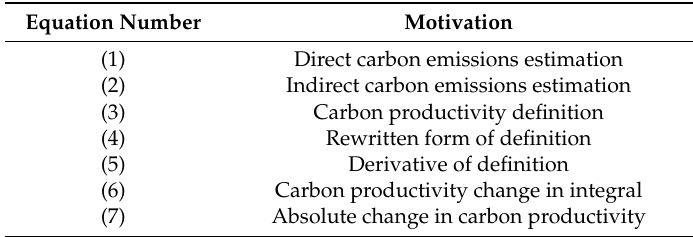
Table 2. The purpose of each equation.